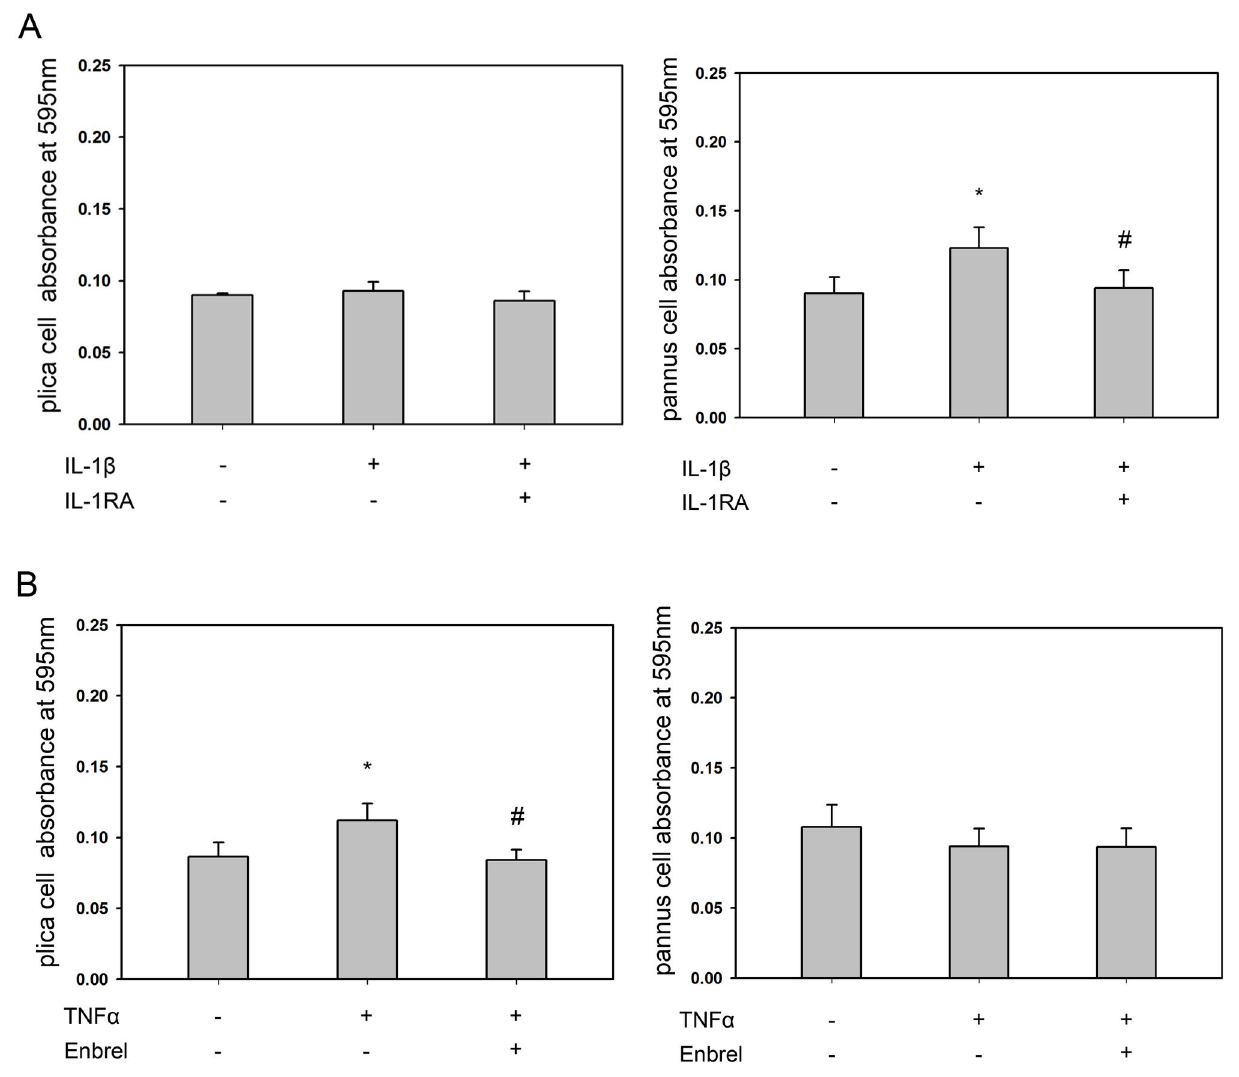
Figure 6. Migration assay of cells from medial plica and pannus-like tissue after treatment with IL-1β or TNF-α with or without a cytokine inhibitor. The medial plica (left panels) and pannus (right panels) cells were treated for 24 h with (A) medium or 50 ng/ml of IL-1β either alone or together with 100 ng/ml of IL-1β antagonist (RA) or (B) medium or 100 ng/ml of TNF-α either alone or together with 100 ng/ml of Enbrel ® , then the cells were fixed and stained with crystal violet and the OD bar represents the mean ± standard deviation for 6 separate experiments (* p < 0.05 versus control, #p < 0.05 versus cytokine alone). doi: 10.1371/journal.pone.0079662.g006 Effect of IL-1β or TNF-α on the migration of cells from plica and pannus-like tissue from stage IV patients To examine the effect of IL-1β or TNF-α on the migratory abilities of cells isolated from plica and pannus-like tissue, the cells were seeded into the upper chamber of a porous membrane cell culture insert and allowed to migrate for 24 h across the membrane in the presence or absence of IL-1β or TNF-α or in the presence of IL-1β and IL-1 receptor antagonist (IL-1 RA) or TNF-α and the TNF-α inhibitor Enbrel. As shown in Figure 6A, IL-1β had no effect on the migration of plica-derived